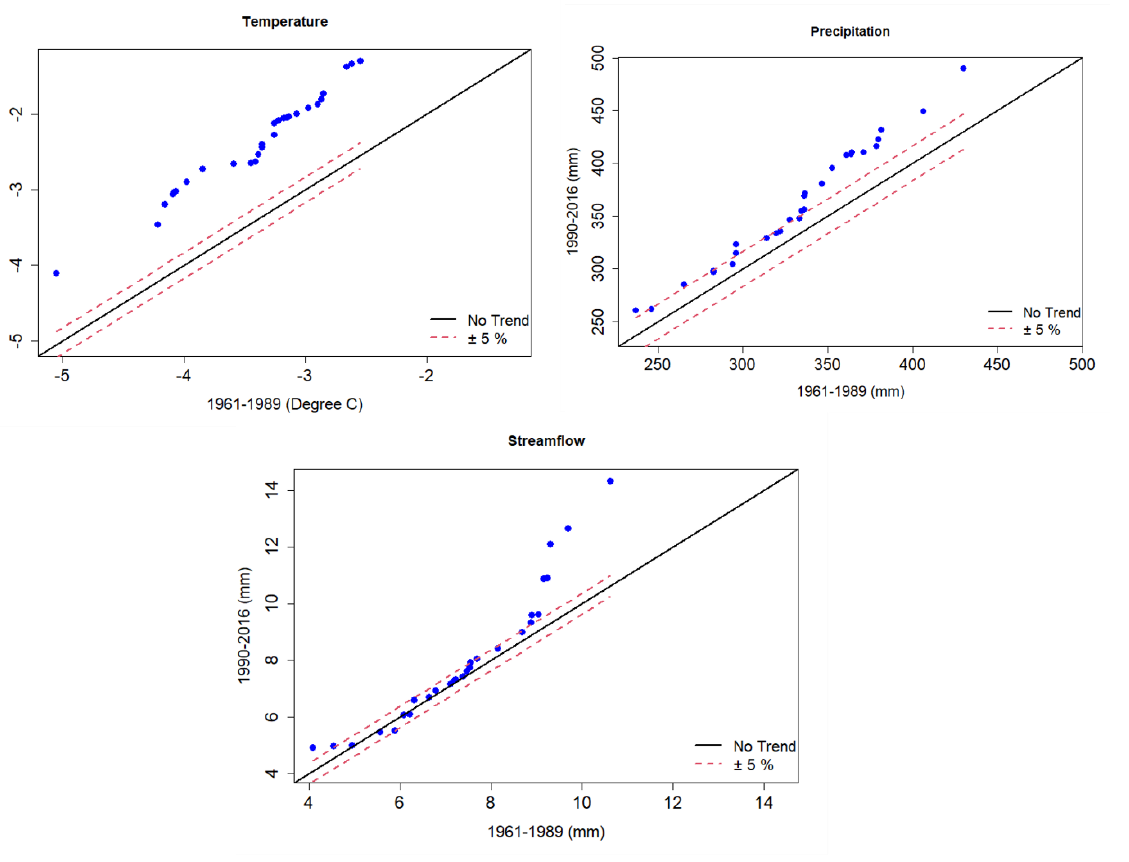
Figure 5. Innovative trend analysis (ITA) results for annual mean temperature, precipitation and streamflow during 1961–2016. Table 2. Annual and monthly slopes per decade using ITA test for mean temperature, precipitation and streamflow time